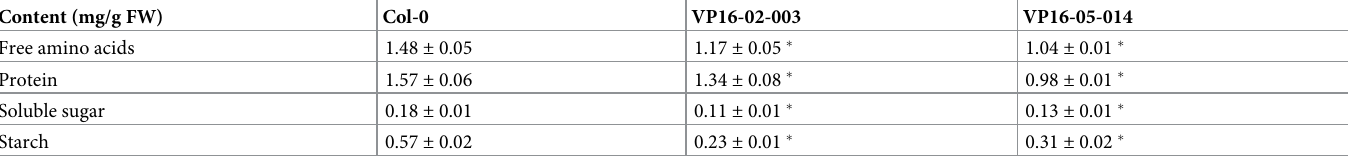
Table 1. Total free amino acids, protein, soluble sugar and starch content in mg/g fresh weight for leaves of Arabidopsis thaliana Col-0, VP16-02-003 and VP16-05- 014. Content (mg/g